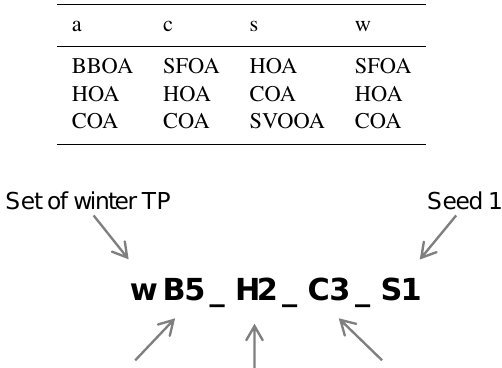
where p is the number of factors chosen, n the number of samples and m the mass spectra. Ideally, if the model accu- rately captured the variability of the measured data, it would be expected to have a value of Q / Q exp = 1, but this value depends on fluctuations in the source profiles, over- or un- derestimation of input data errors and the model